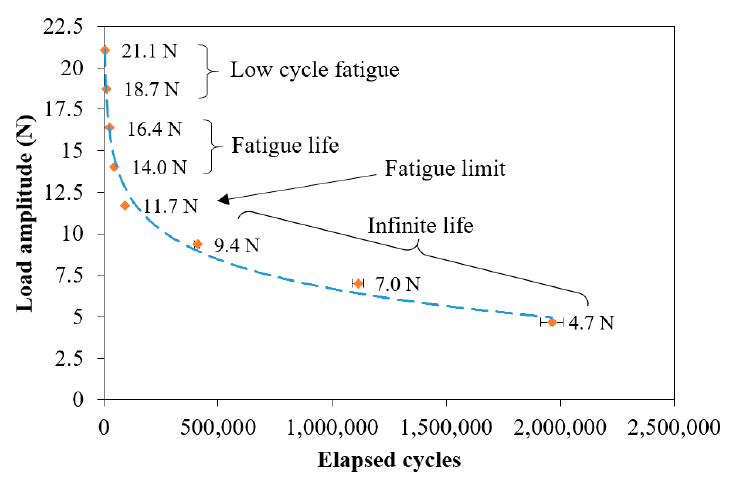
Figure 6. Whöler curve of the TiO 2 /UHMWPE joints with the different fatigue zones. Table 2. Dynamic parameters of the fatigue tests of the TiO 2 /UHMWPE joints (1 wt% of TiO 2 ).